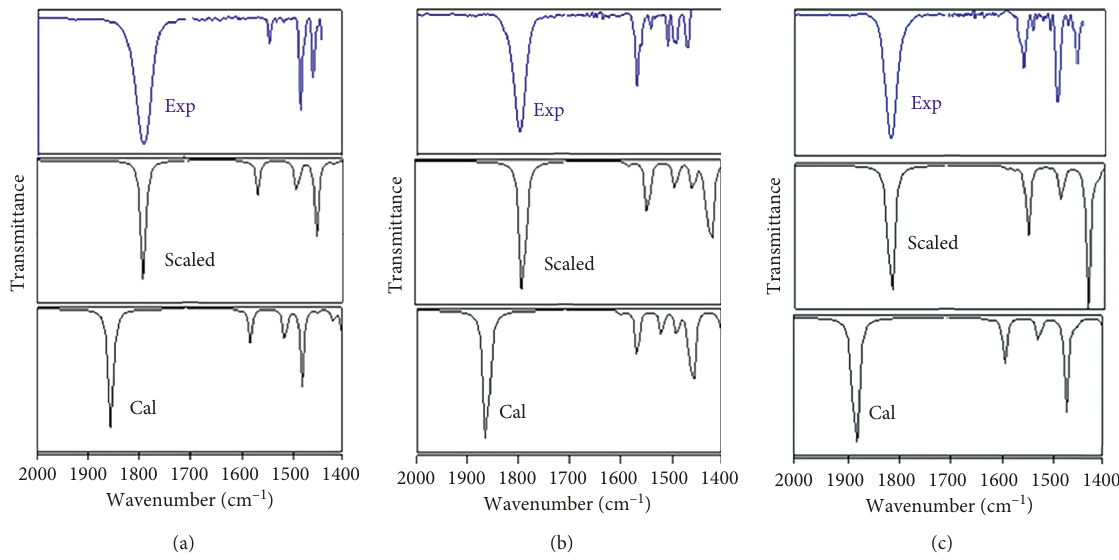
Figure 4: Recorded and calculated IR spectra of [RuCl 3 (hqn)NO] 1 region (blue: experimental; black: calculated). − − 1 ) Table 3: Observed and calculated vibrational frequencies (cm 1 region for [RuCl , and intensities over 2000–1400cm − 3 (hqn)NO] [RuCl 3 (2mqn)NO] , and [RuCl 3 (2cqn)NO] complexes. − − − [RuCl 3 (hqn) [RuCl 3 (2cqn) NO] NO] Assignment − − Exp. Cal. Exp. Cal.